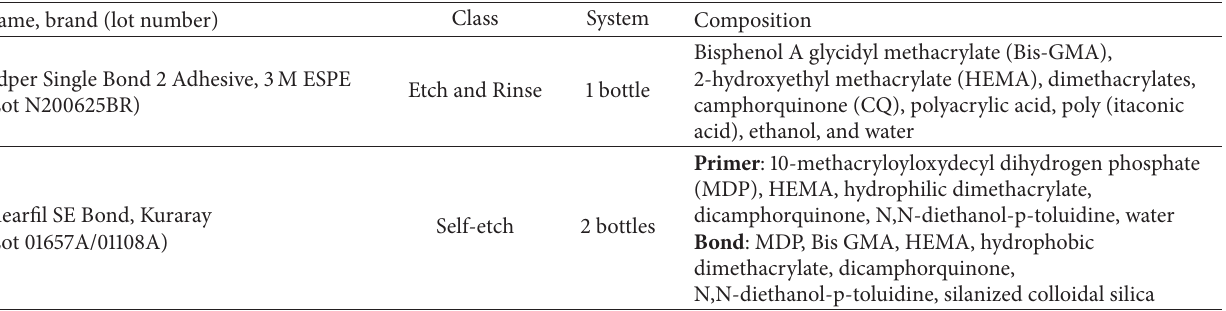
Figure 1: Characterization of the stem cells from human exfoliated deciduous teeth through the expression profile of mesenchymal stem cell markers: STRO-1 (a) and CD146 (b). Observe the positivity to both markers. Table 1: Adhesives